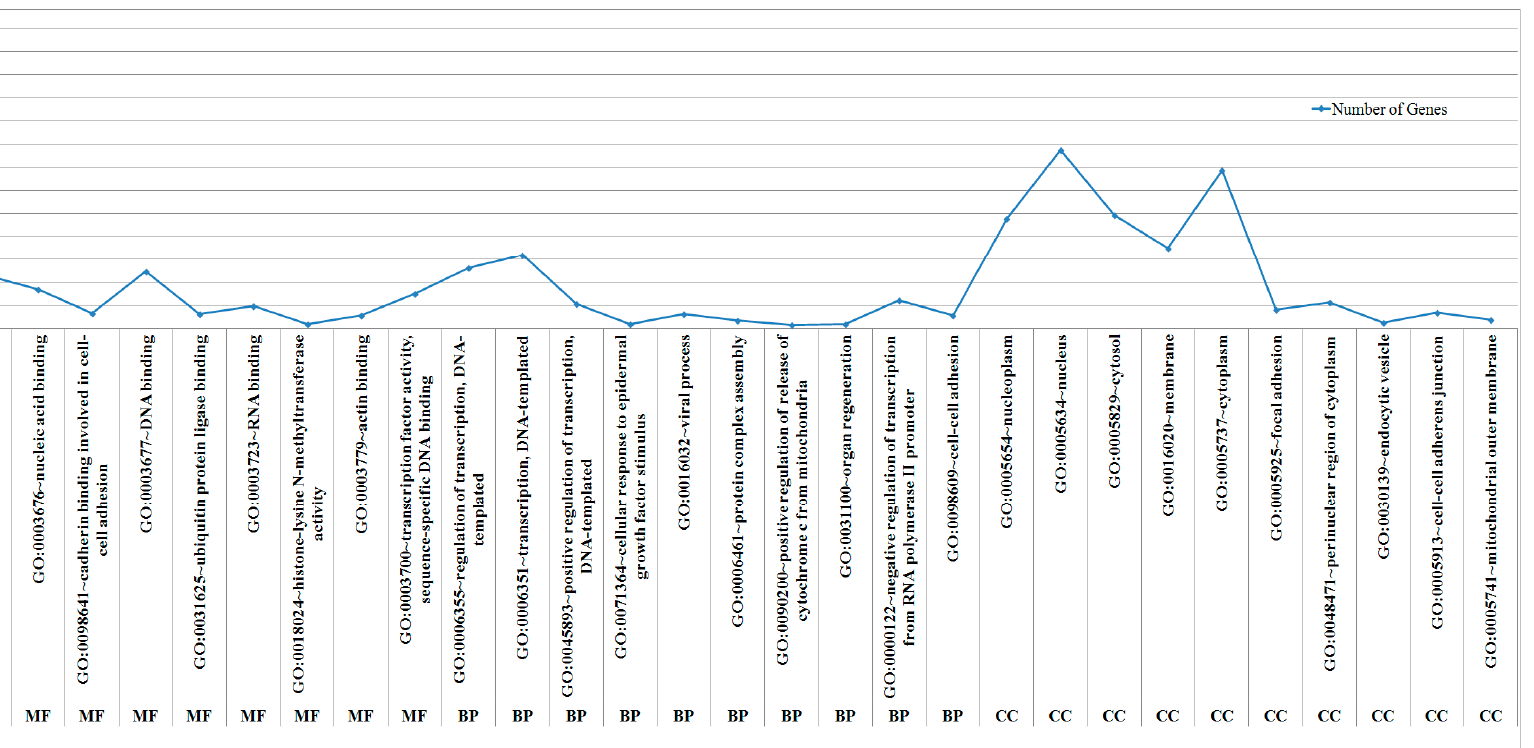
Figure 3. GO enrichment analyses illustrated the significantly enriched target genes of miRNAs in biological processes (BP), cellular component (CC), and molecular function (MF).